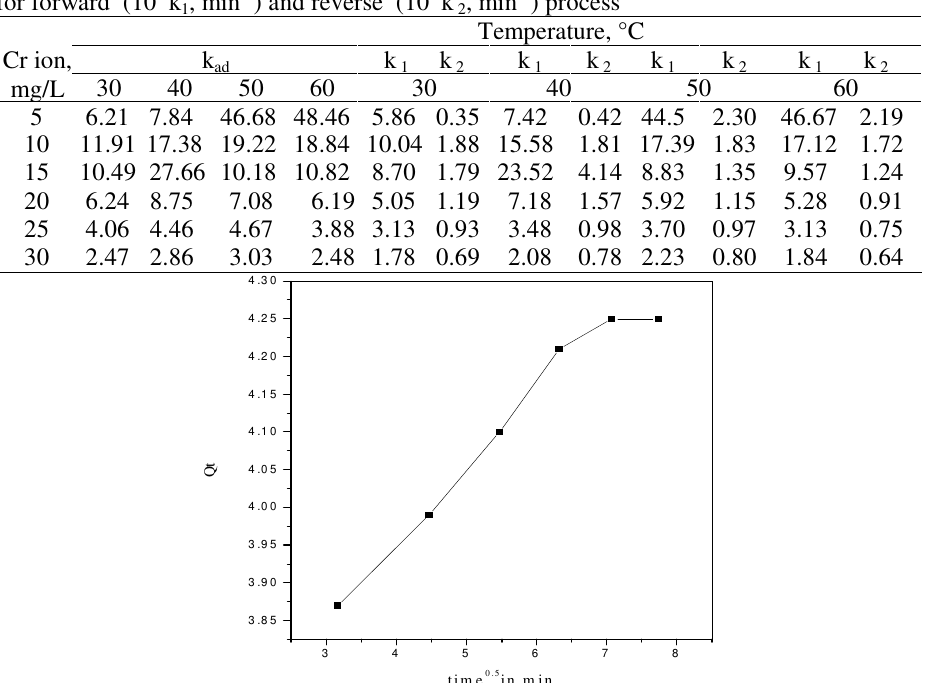
time 0.5 in min Figure 5. Inteaparticle diffusion effect on the adsorption of chromiumion onto PDC[Cr]=20 mg/L, pH=7; Dose=50 mg/50